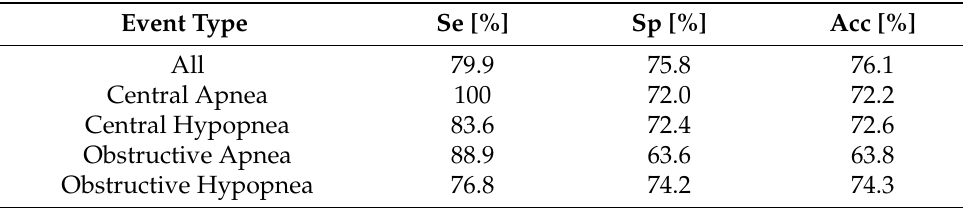
Table 6. Apnea/Hypopnea Detection results on patients with AHI ≤ 5.